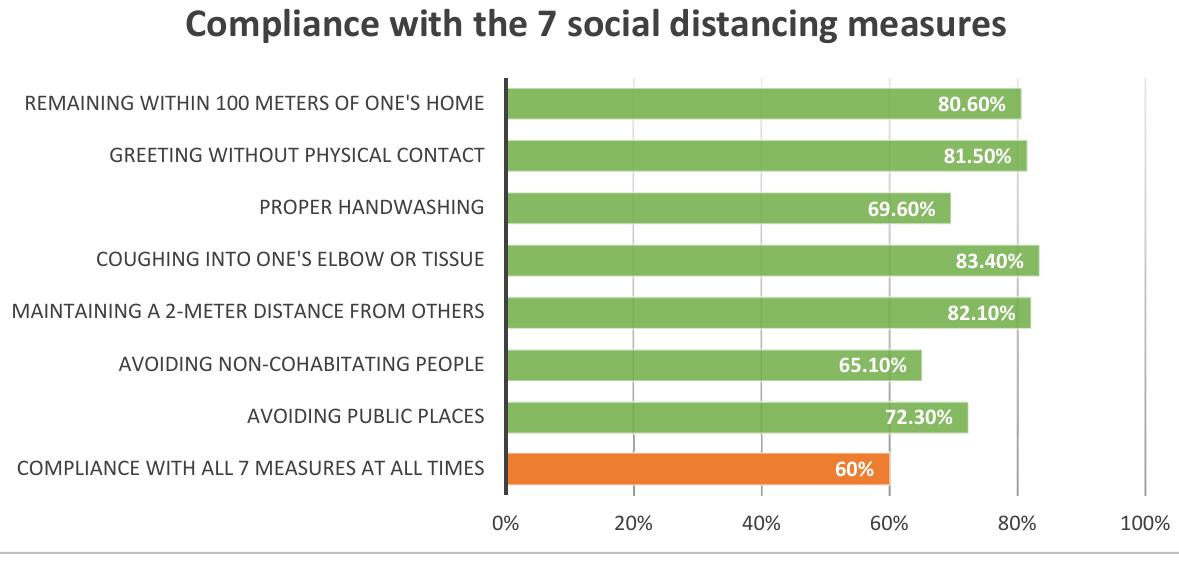
Figure 1. Compliance with the 7 social distancing measures.